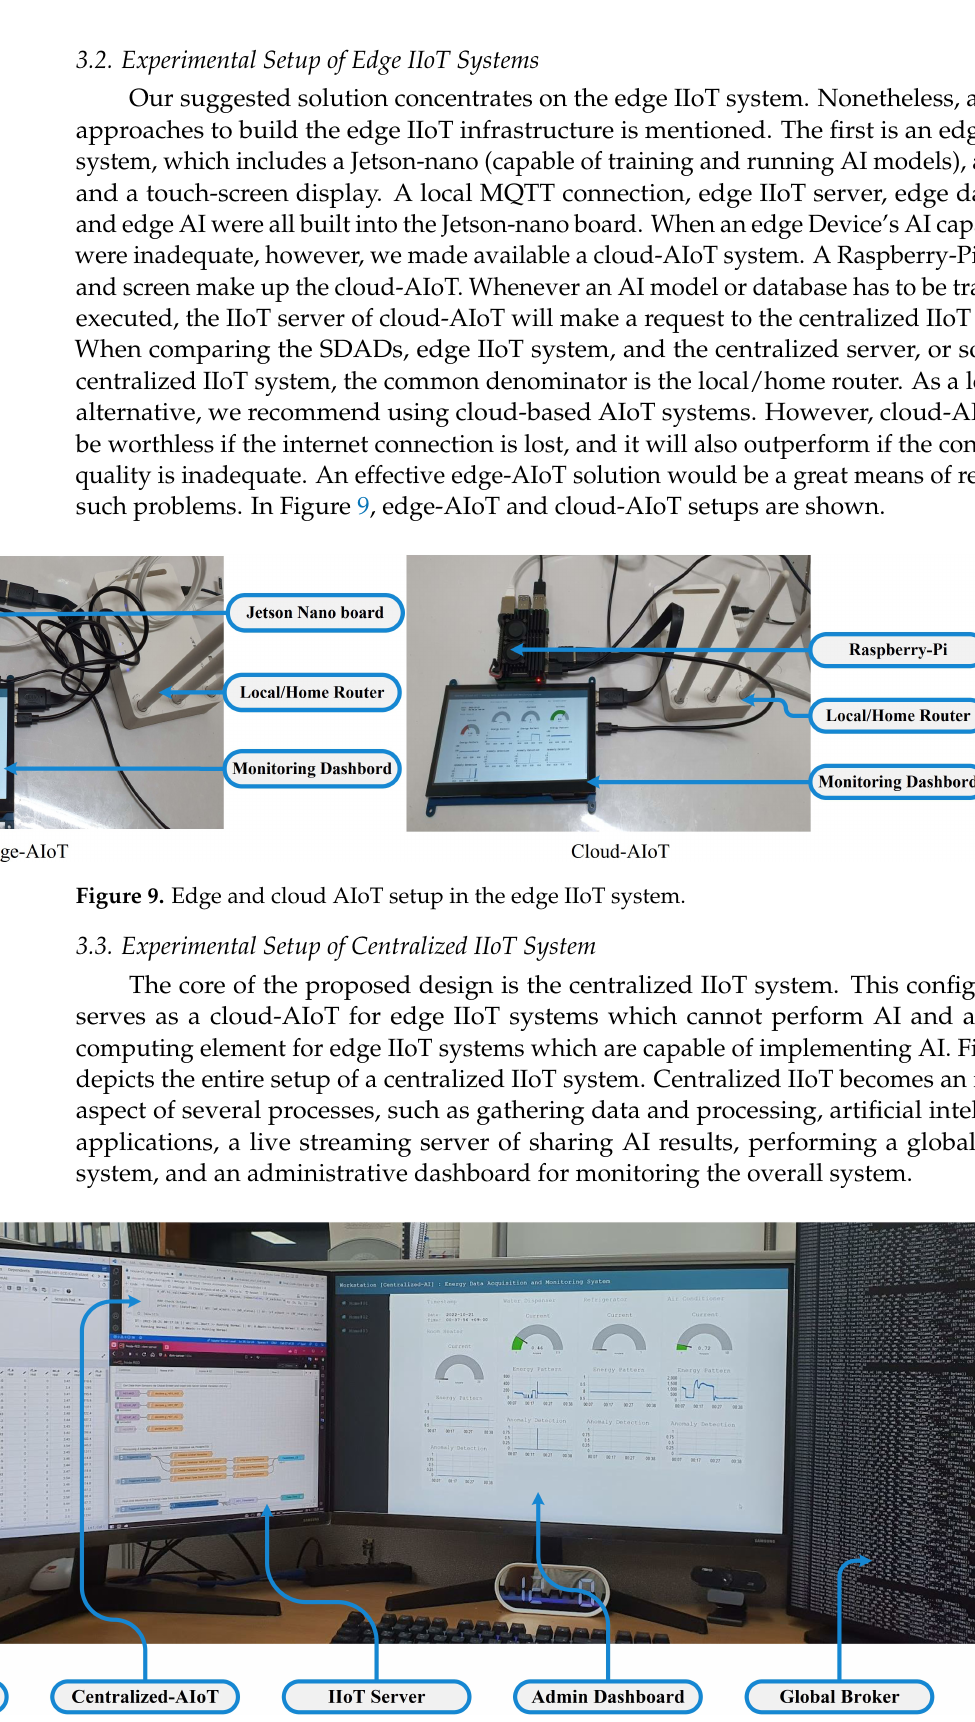
Figure 10. Setup of the centralized IIoT